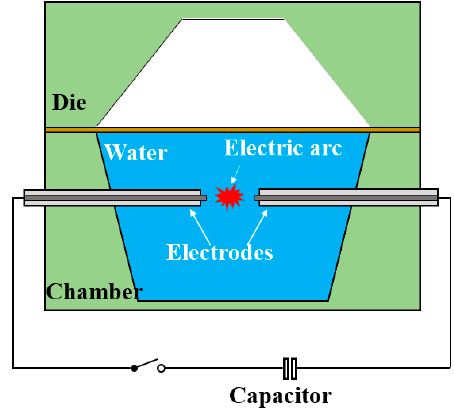
Figure 1. A schematic view of electrohydraulic forming apparatus.